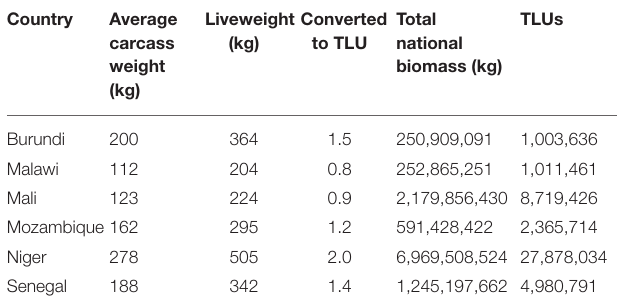
TABLE 1 | Herd biomass estimates derived from a standard average of 175kg per head. Country